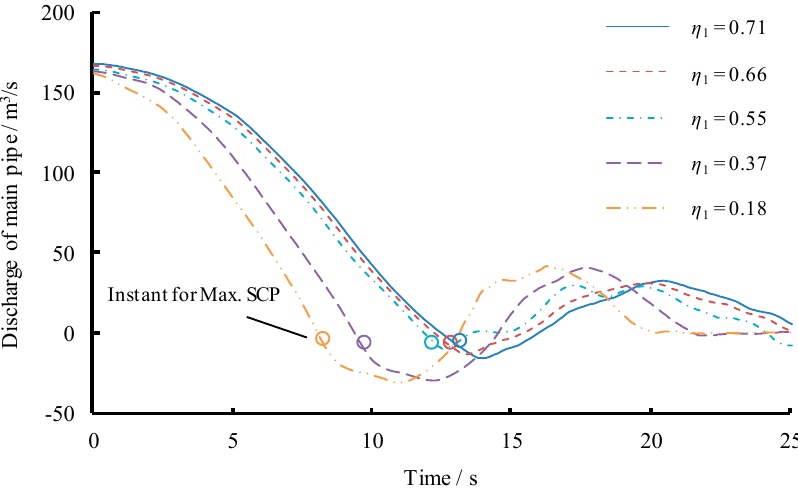
Figure 10. Discharge of the main and branch pipes versus time during SLR and TLR for η 1 = 0.18.